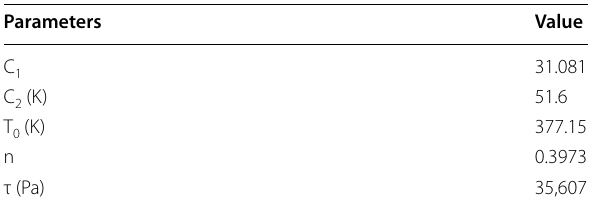
Table 3 Parameters of cross-WLF model for PMMA experi- ment